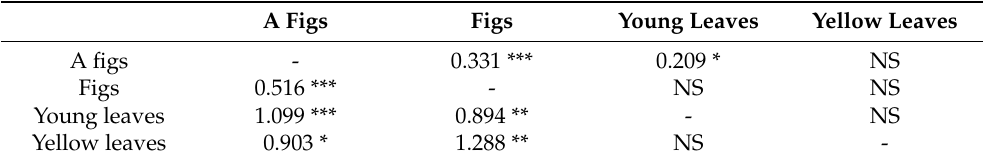
Table 2. Correlation coefficients of the generalized least (GLS) models with autocorrelated errors between the phenological characteristics of the male (below) and female (above) trees.